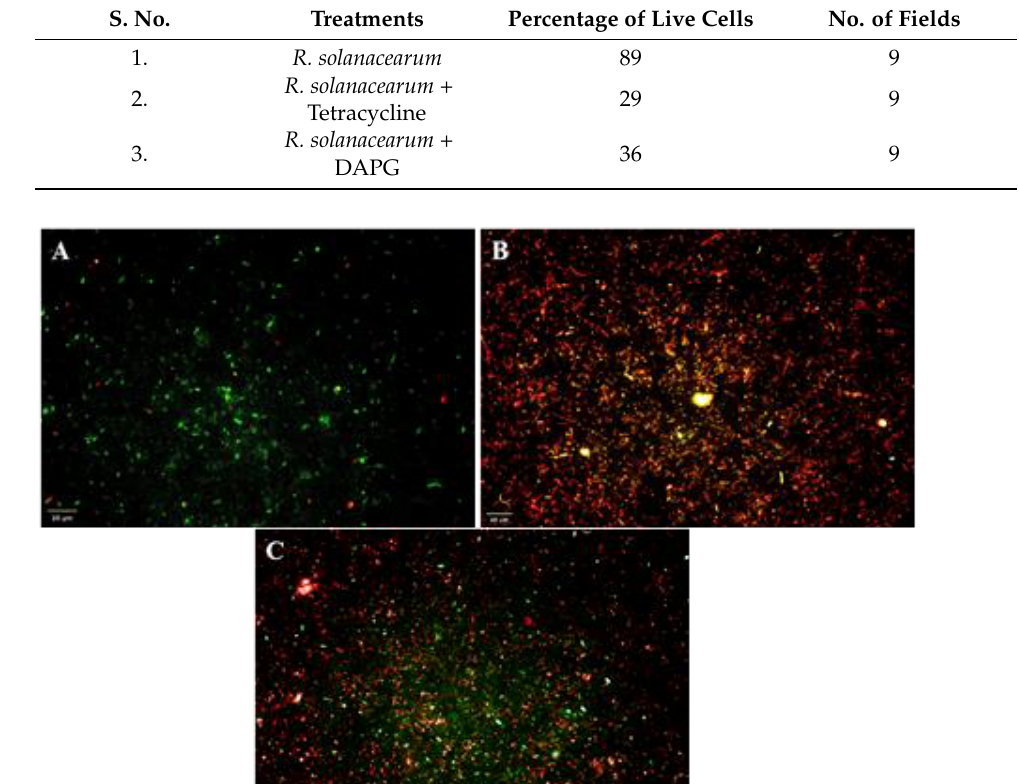
17 of 27 Figure 6. MIC of DAPG compound against R. solanacearum . ( A ) Different concentrations of DAPG metabolites against R. solanacearum and ( B ) 90 µg/mL concentration of tetracycline and DAPG. 3.9. Live/Dead Cell Assay of R. solanacearum